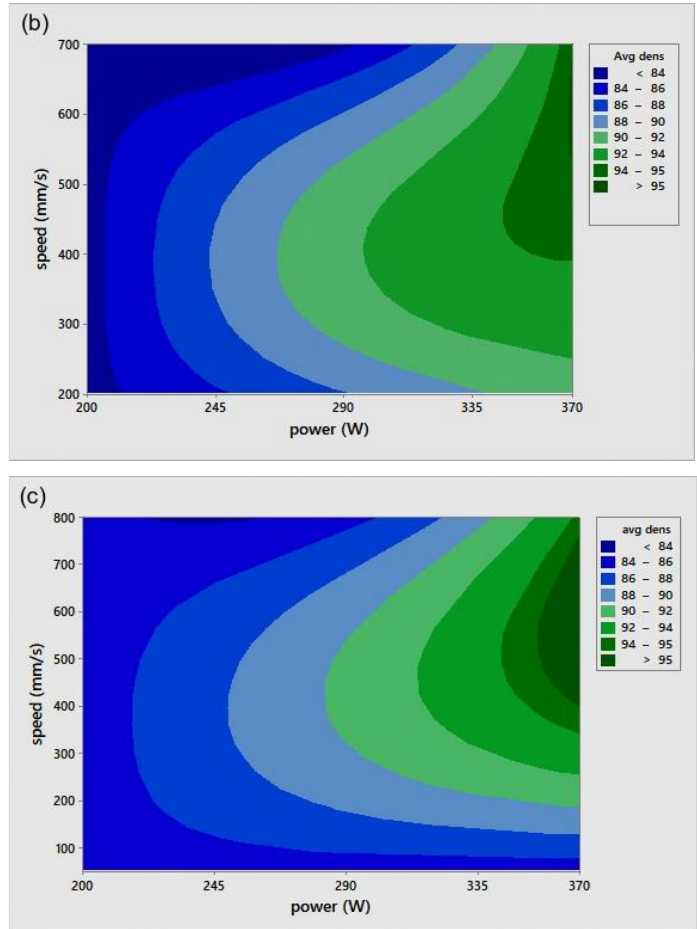
Figure 4. Scan speed ( v )-laser power ( P )-relative density (RD) maps for different hatch spacing ( h ) values: ( a ) h = 0.05 mm, ( b ) h = 0.08 mm, and ( c ) h = 0.1 mm.